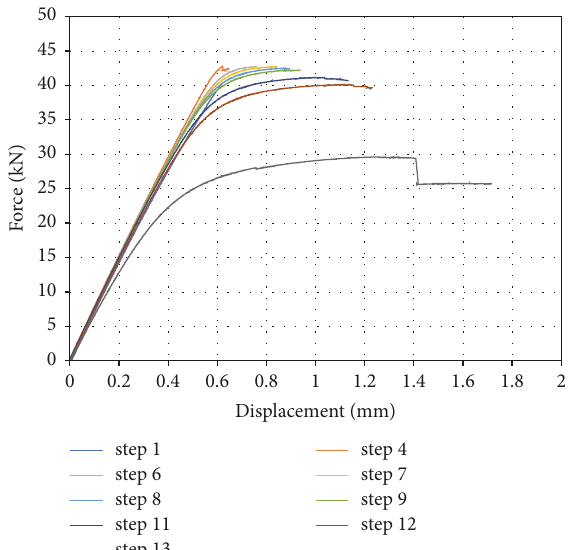
Figure 9: Force-displacement curves for the side delamination.